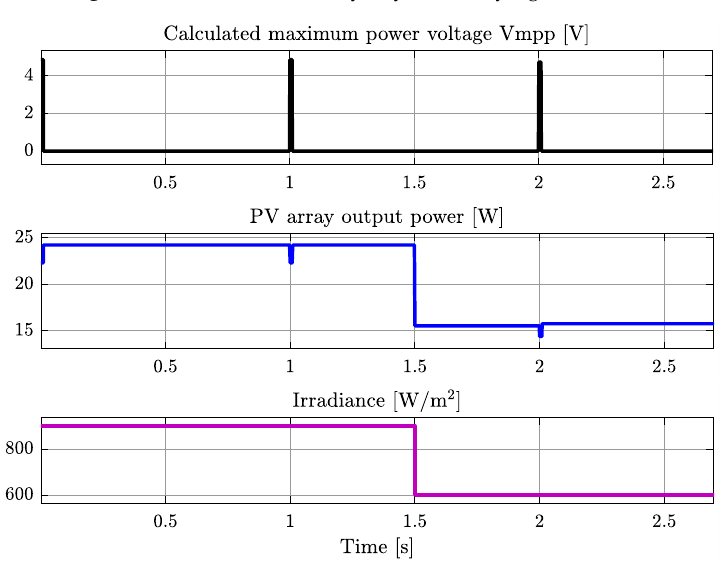
Figure 11. Scenario 2: Cloudy day with varying irradiance.